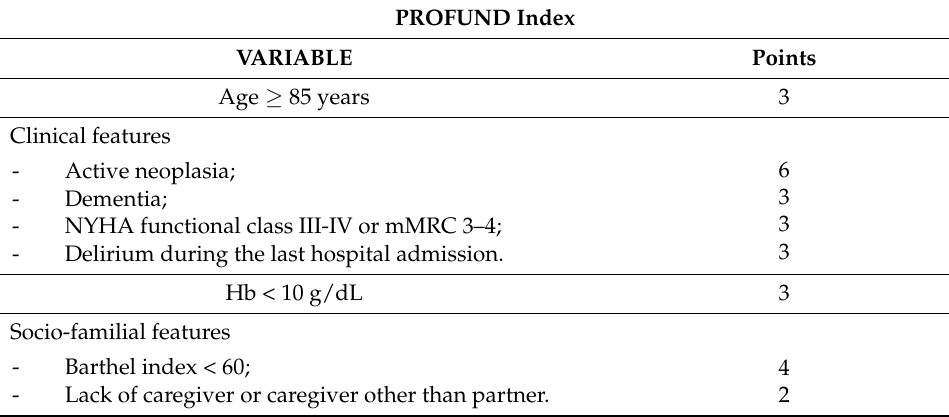
Table 1. PROFUND scale